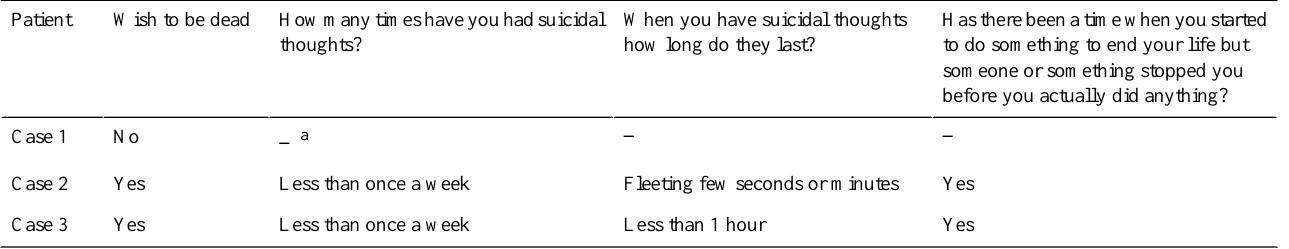
Table 3. Characteristics of the most recent suicide